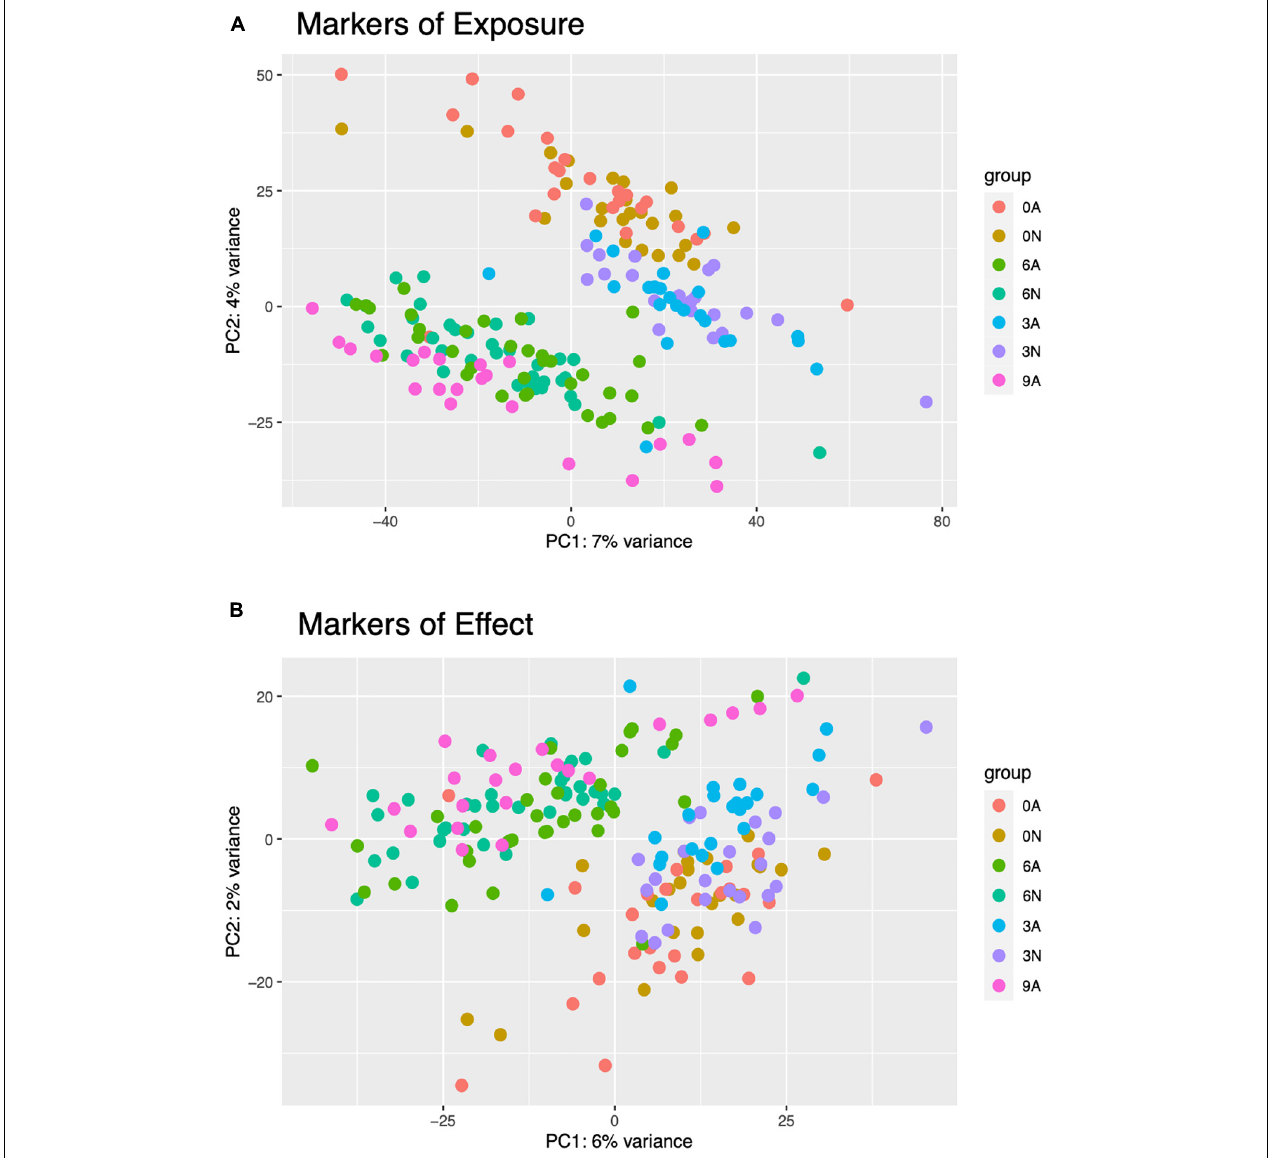
FIGURE 5 | PCA plots were created for single larval markers of exposure (A) and effect (B) . Point colors are unique to combined copper concentration (0, 3, 6, or 9 µ g/L) and morphologies (N, normal, or A, abnormal). Counts were normalized in DESeq2 and transformed with variance stabilizing transformation (vst) prior to